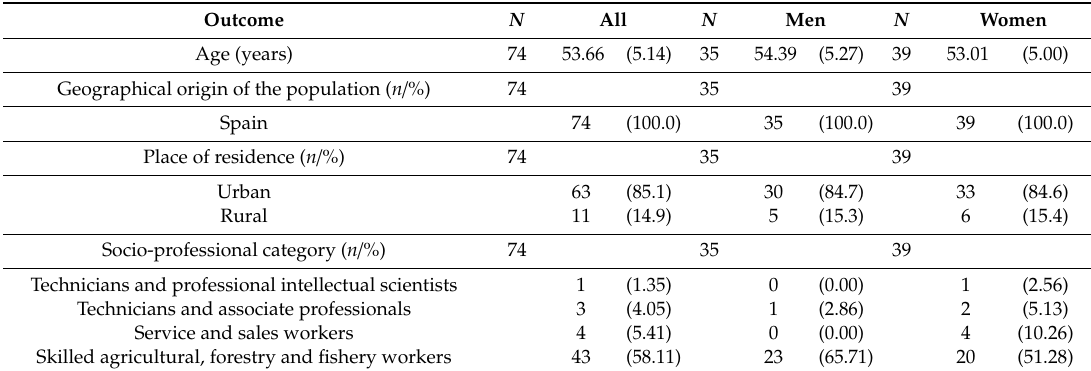
Table 1. Descriptive